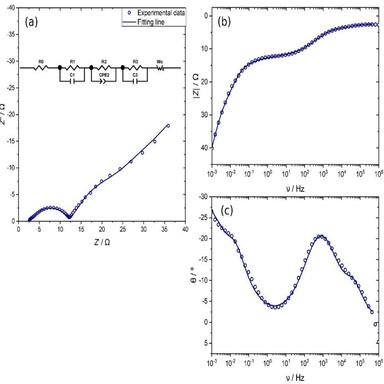
Impedance spectra of a bi-layered HCC after the formation cycle and the corresponding fitting. (a) Nyquist plot and the equivalent circuit used for the fitting. (b, c) Corresponding Bode plots.